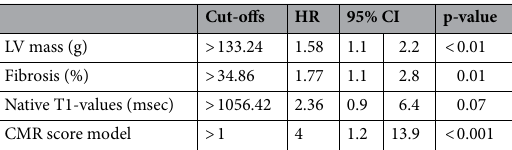
Table 4. Clinically relevant cut-offs for CMR variables including the CMR score